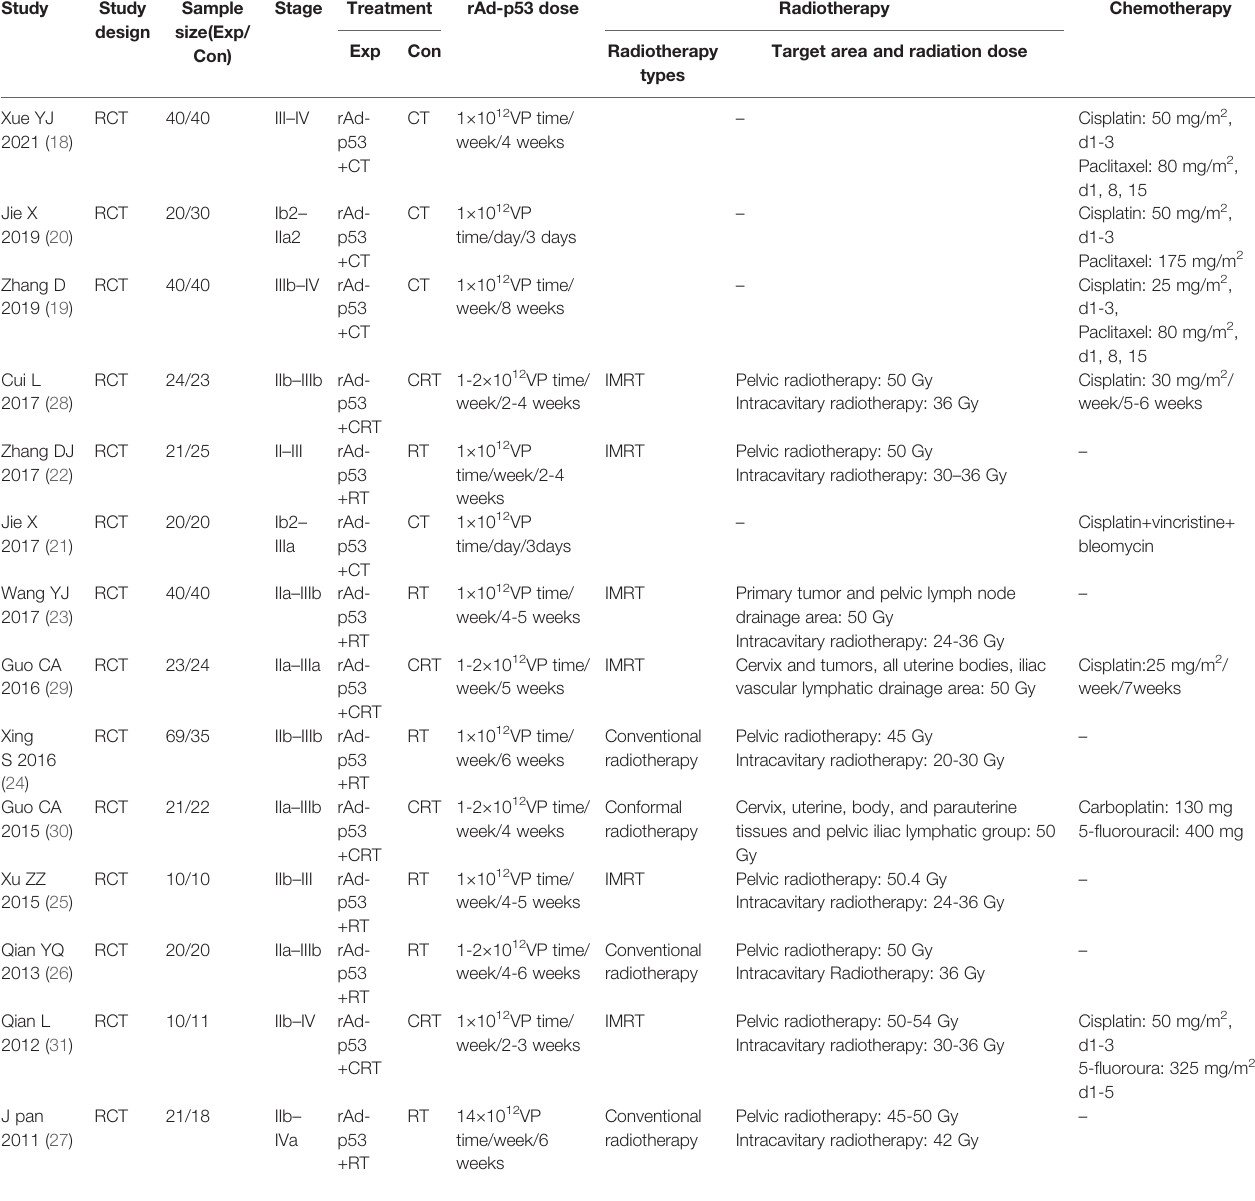
TABLE 1 | Characteristics of studies